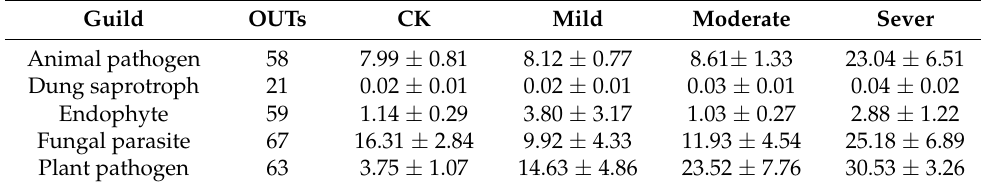
Table 4. The relative abundance (%) of different fungal functional guilds under salt stress.